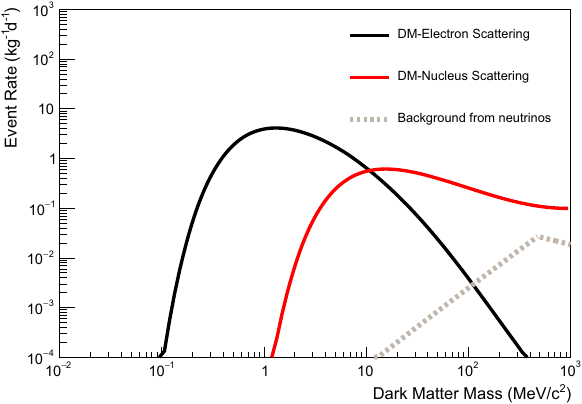
Fig. 13 Shown is the projected experimental sensitivity for 1 kg-day exposure. DM-electron scattering, under the light mediator with a dark photon, is more sensitive to the mass of DM below 1 MeV/c 2 while comparing to DM-nucleus scattering